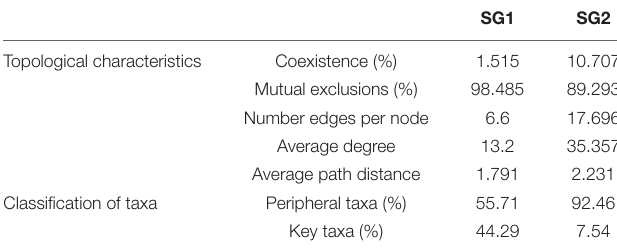
TABLE 1 | The features of the co-occurrence networks in two subgroups.